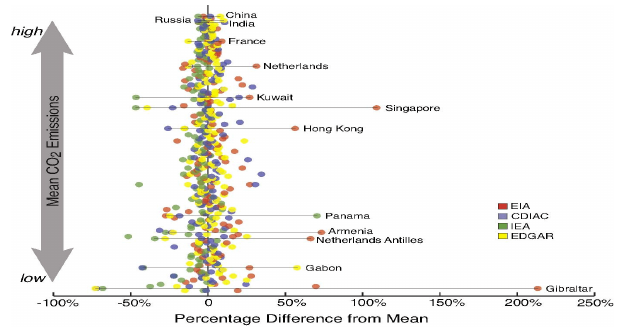
Fig. 2. Differences in total emissions reported by CDIAC, IEA, EIA, and EDGAR for 133 nations in 2007. The nations are spread along the y-axis according to their rank-order of mean FFCO2 emissions as reported in the respective data sets. Points near zero on the x-axis reflect small differences among the total emissions reported. Outliers reflect larger differences related to the disparate methodologies underlying reported emissions, for instance whether or not emissions from international bunker fuels and calcining of limestone are included.